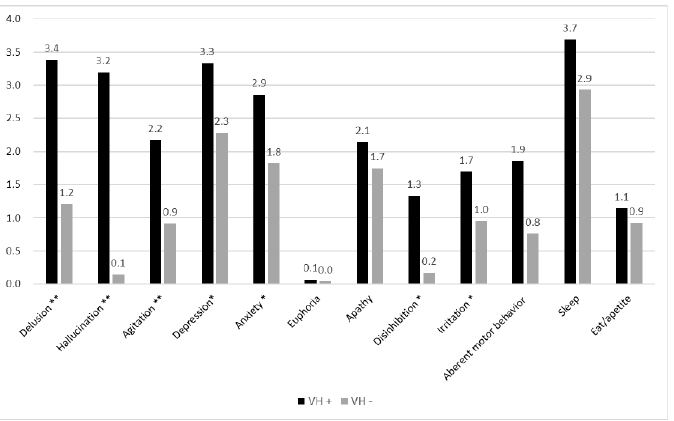
Fig 1. Comparison of the subscale scores in the twelve-item NPI between the VH+ and VH − AD groups. AD, Alzheimer’sdisease;VH, visual hallucination. * p < 0.05; ** p < 0.005.